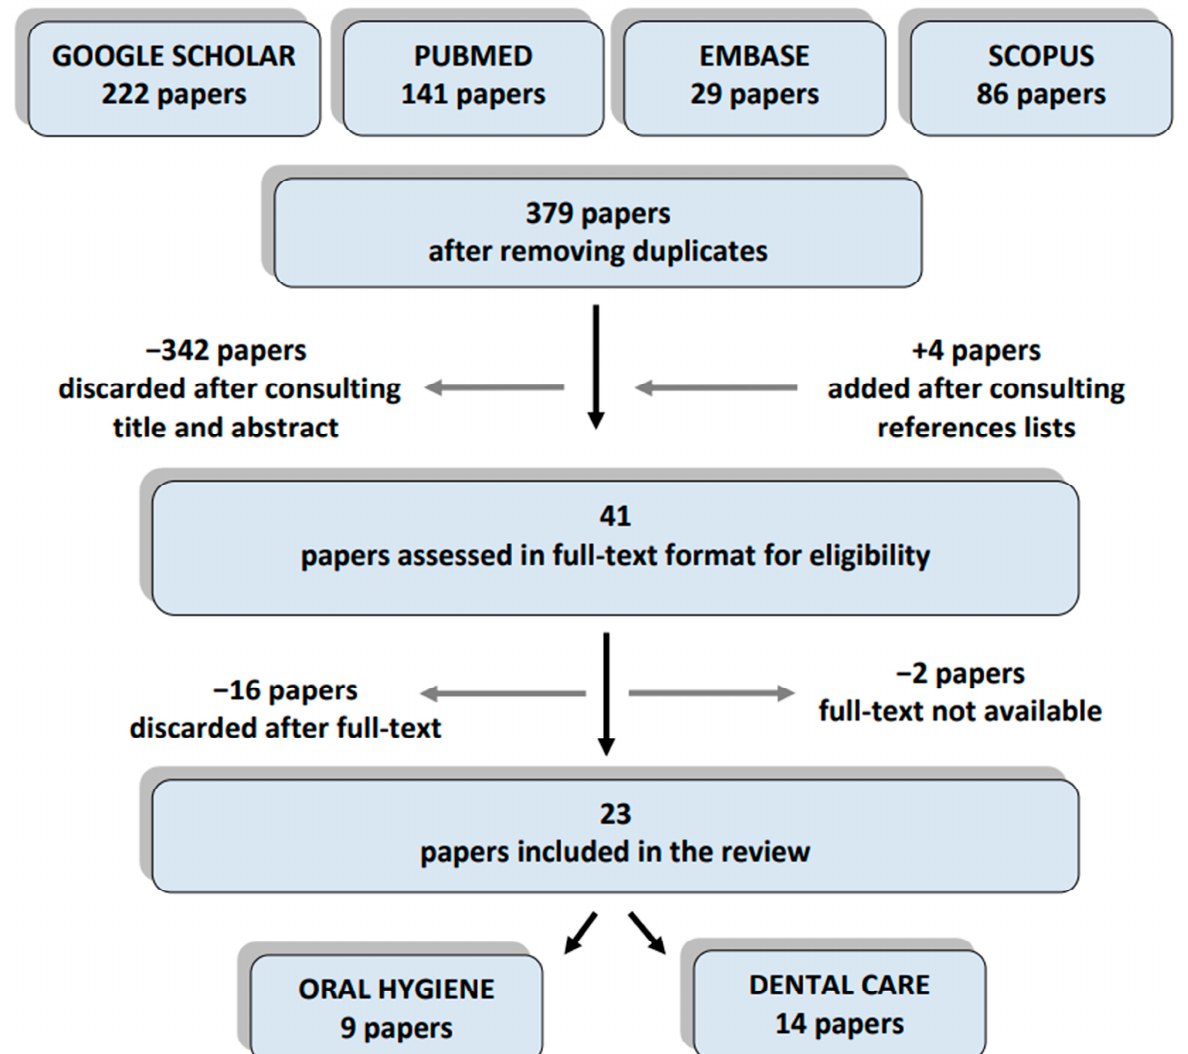
Figure 1. Flow chart of the